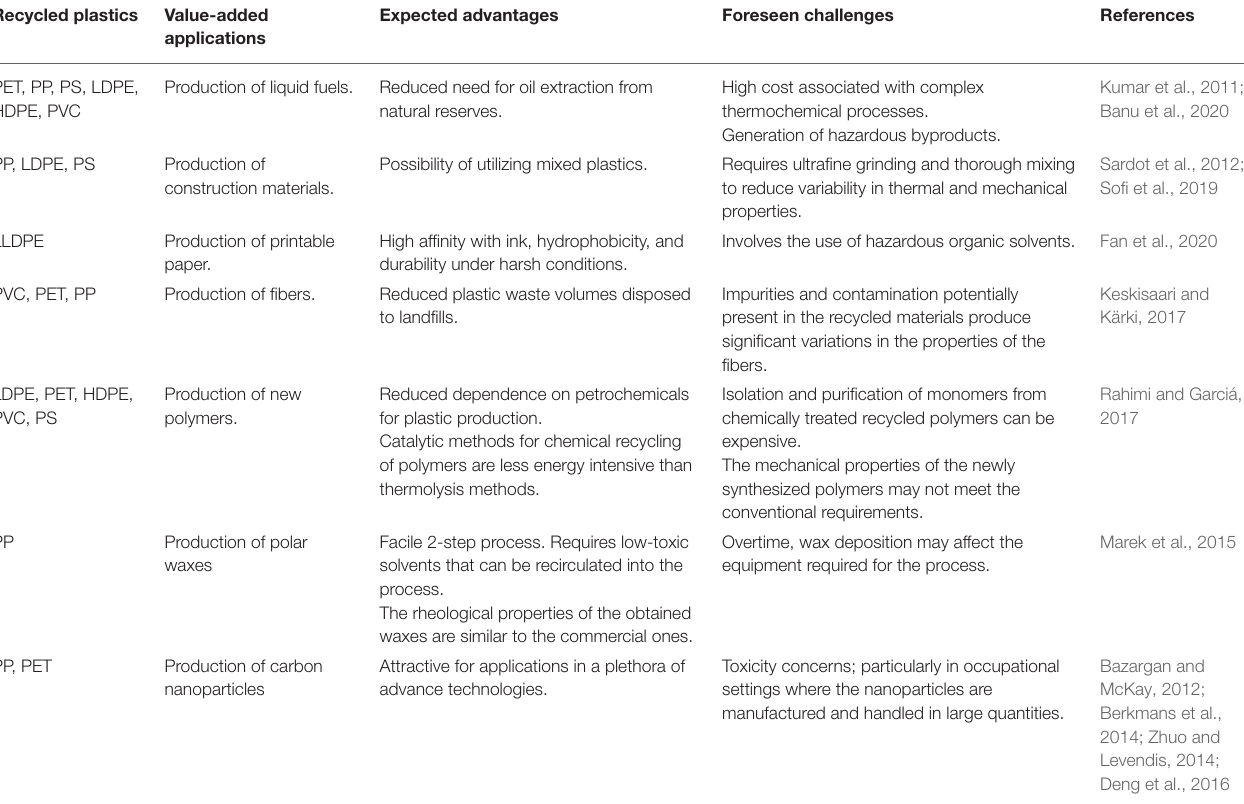
TABLE 3 | Potential value-added applications for recycled